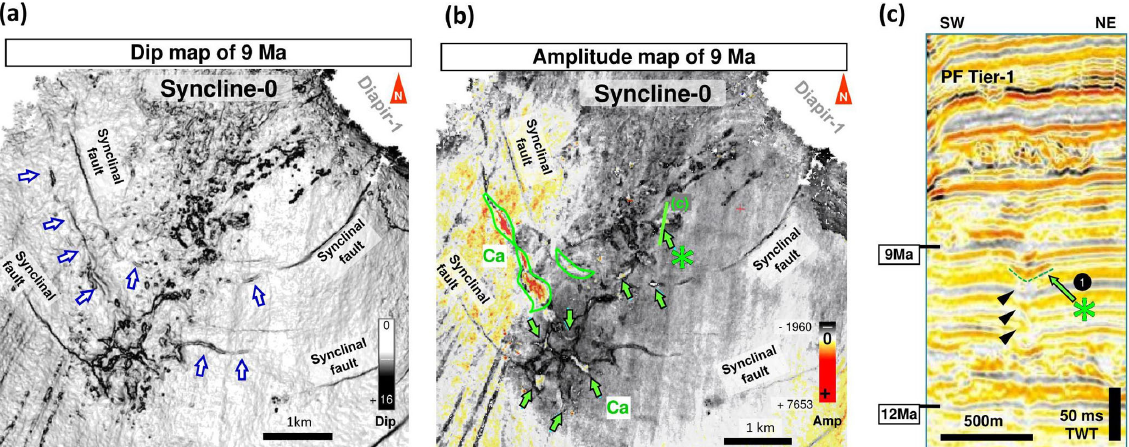
Figure 13. Kilometre-scale Linear Chimneys along the tectonic faults of Syncline-0. (a) Dip map and (b) amplitude map of horizon 9Ma showing the geometry of a radial network of positive high-amplitude depressions that overlays a big Linear Chimney network. Green star locates the PHAA depression shown in (c) . (c) Zoom of seismic profile in Fig. 2b showing a PHAA within the radial network overlying a chimney. Black arrows indicate the chimney. Numbered black-filled circle indicates the type of chimney. See green dotted line in (b) for